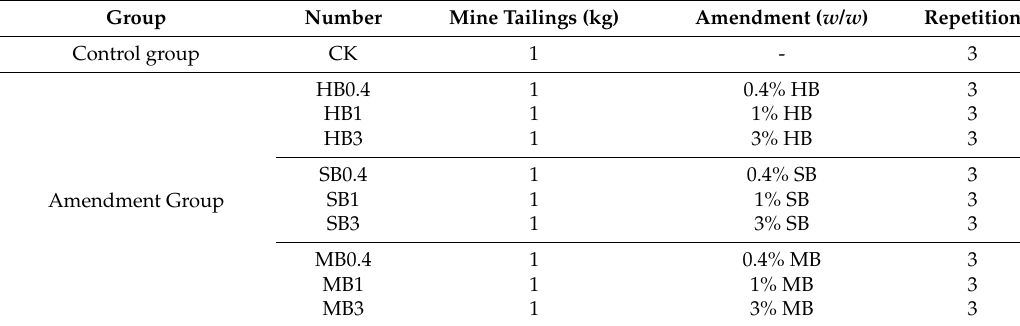
Table 2. Experimental design for pot